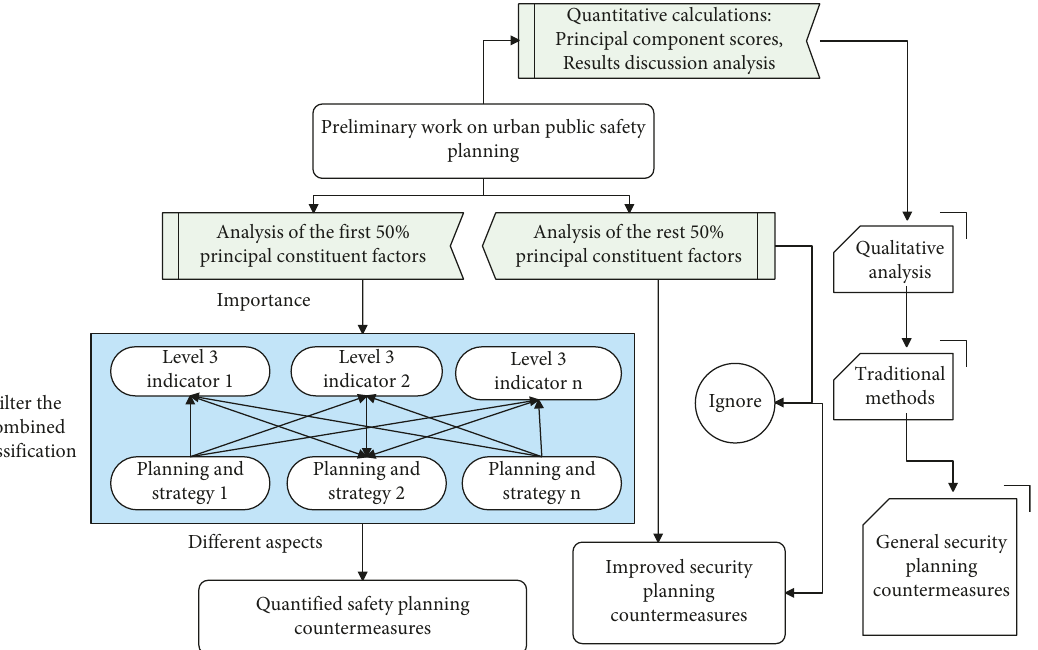
Figure 6: Smart city public safety